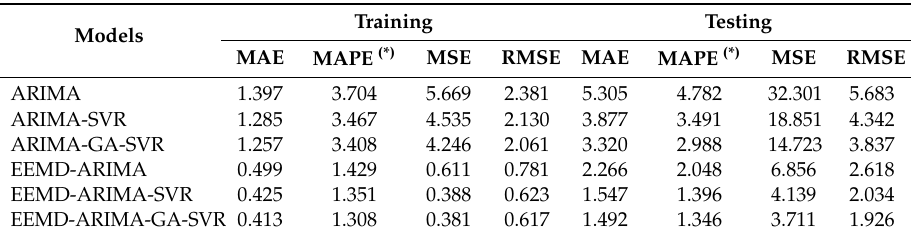
Table 4. Comparison of forecasting